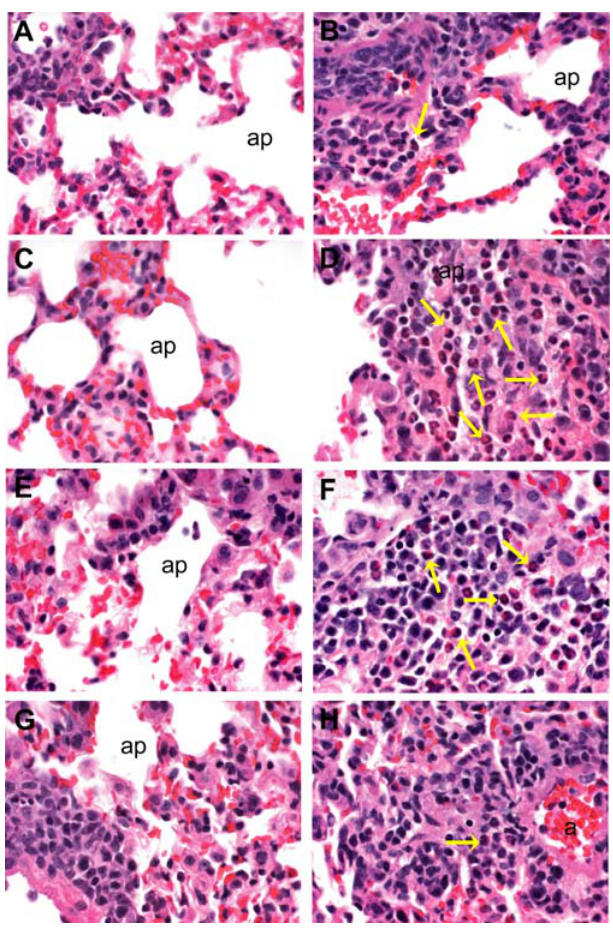
Figure 10. Identifying Eosinophils among Inflammatory Infiltrates The 400 3 magnification comparing eosinophil infiltration within the lung sections of VRP-HA–vaccinated (A), (C), (E), and (G) and VRP-N–vaccinated (B), (D), (F), and (H) mice (Table 1, Experiment 5). At day 2 post-infection (A) and (B), eosinophils are rarely evident in the lungs of either VRP-HA (A) or VRP-N (B) mice. Day 4 post-infection (C) and (D), extensive eosinophils (yellow arrows) are present within the lungs of VRP-N– vaccinated mice. Widespread eosinophils are seen at day 7 post- challenge in VRP-N–vaccinated (F), but not VRP-HA–vaccinated (E) mice. By day 14 (G) and (H), eosinophils are rarely found among inflammatory cells of VRP-N–vaccinated mice. An identical experiment in old animals was performed simultaneously (Table 1, experiment 6), showed results indistinguishable from those of young mice (unpublished data). All tissues were stained with hematoxylin and eosin.